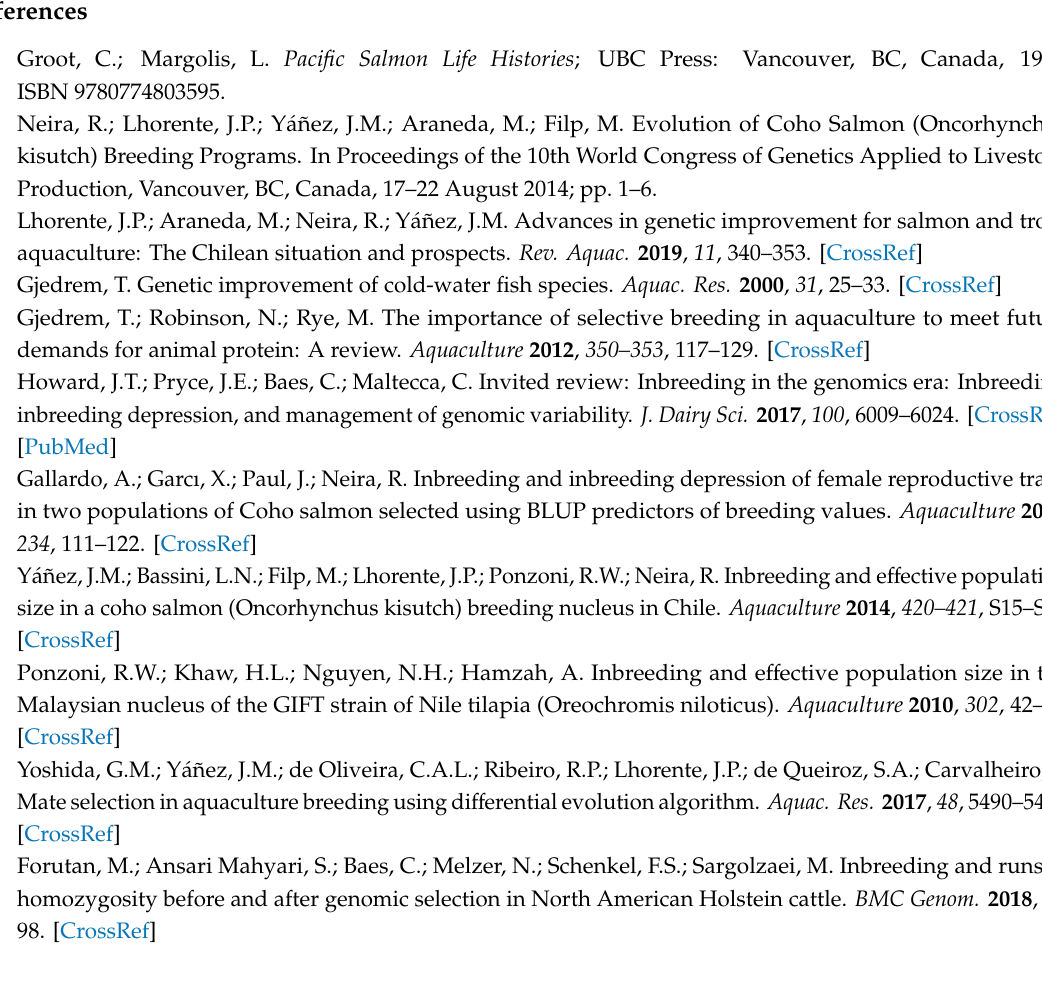
Table S1: Summary of results from quality control of SNP genotypes. Figure S1: Admixture clustering of the three coho salmon population for K = 4. Figure S2: Runs of homozygosity patterns for all chromosome coho salmon populations. Figure S3: Scatterplots and Pearson correlation of inbreeding coe ffi cients for POP A. Figure S4: Scatterplots and Pearson correlation of inbreeding coe ffi cients for POP B. Figure S5: Scatterplots and Pearson correlation of inbreeding coe ffi cients for POP C. Figure S6: Scatterplots and Pearson correlation of inbreeding coe ffi cients across coho salmon